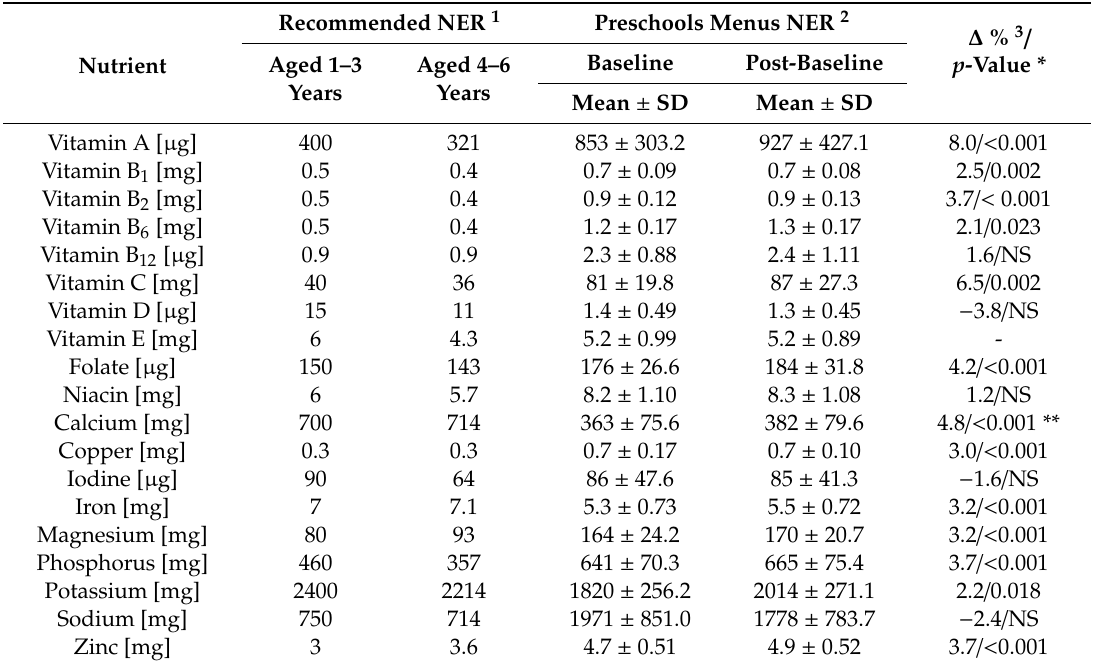
Table 4. The nutrient-to-energy ratio (NER) in 231 preschools’ 10-day menus with reference to the recommended age-specific nutrient-to-energy ratio before (baseline) and after (post-baseline) the education program.